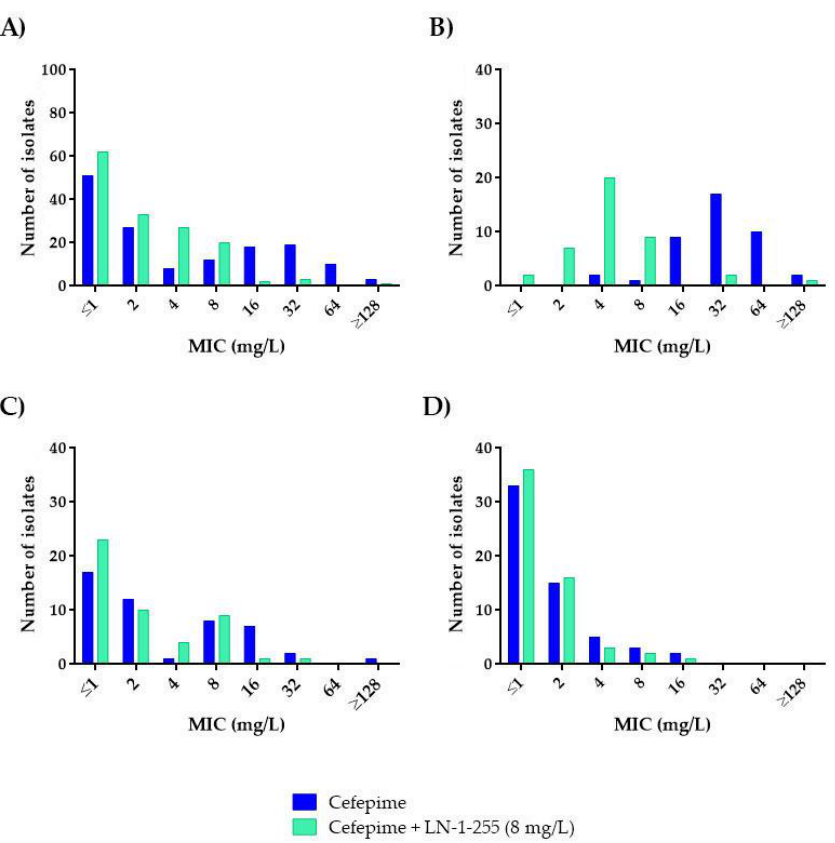
Figure 4. Comparative analysis of cefepime and cefepime/LN-1-255 MICs (mg/L): ( A ) All isolates ( n = 148), ( B ) CHDL-producing A. baumannii ( n = 41), ( C ) A. baumannii producing only OXA-51-like ( n = 48), and ( D ) non- A. baumannii ( n = 59).